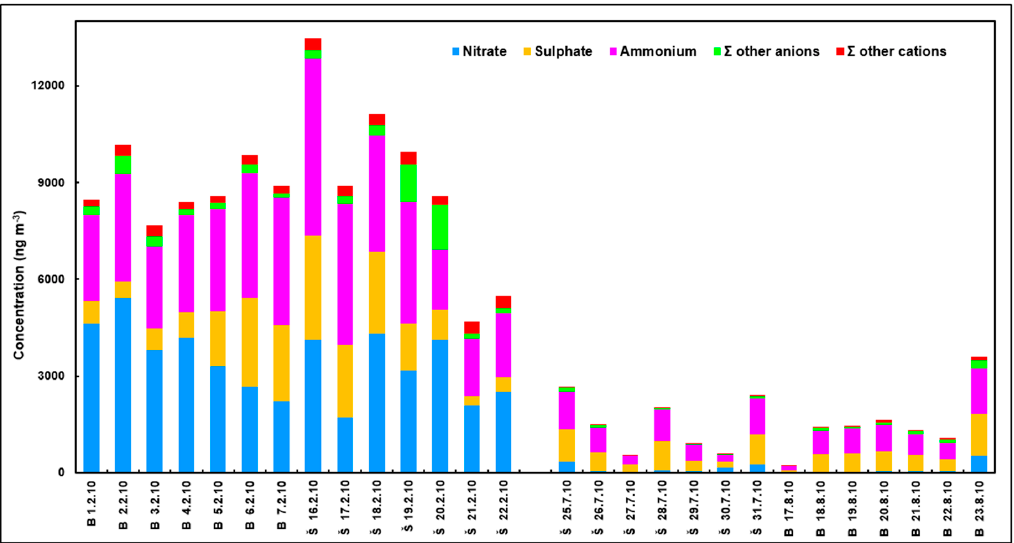
Figure 5. Daily variations in the concentrations of water-soluble ions in the PM 1 aerosols in Brno and Šlapanice in 2010.